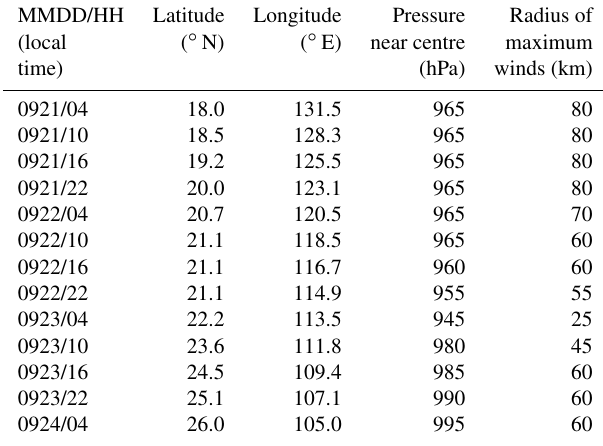
Table 3. Hourly positions, hourly minimum mean sea level pres- sures near the centre, and the radii of maximum winds of the recon- structed possible track of Typhoon 1874 from 08:00 on 22 Septem- ber to 11:00 on 23 September 1874.